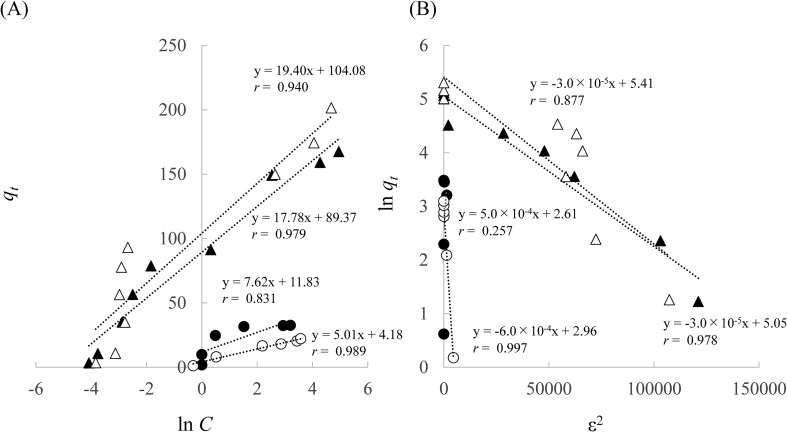
Temkin isotherm plots (A) and Dubinin–Radushkevich isotherm plots (B) for the adsorption of Cd(II). ●: Lig (25 °C, A: y = 7.62x + 11.83, r = 0.831, B: y = 5.0×10−4x + 2.61, r = 0.257), ○: Lig (50 °C, A: y = 5.01x + 4.18, r = 0.989, B: y = -6.0×10−4x + 2.96, r = 0.997), ▲: Lig800 (25 °C, A: y = 17.78x + 89.37, r = 0.979, B: y = -3.0×10−5x + 5.05, r = 0.978), ▵: Lig800 (50 °C, A: y = 19.40x + 104.08, r = 0.940, B: y = -3.0×10−5x + 5.41, r = 0.877).